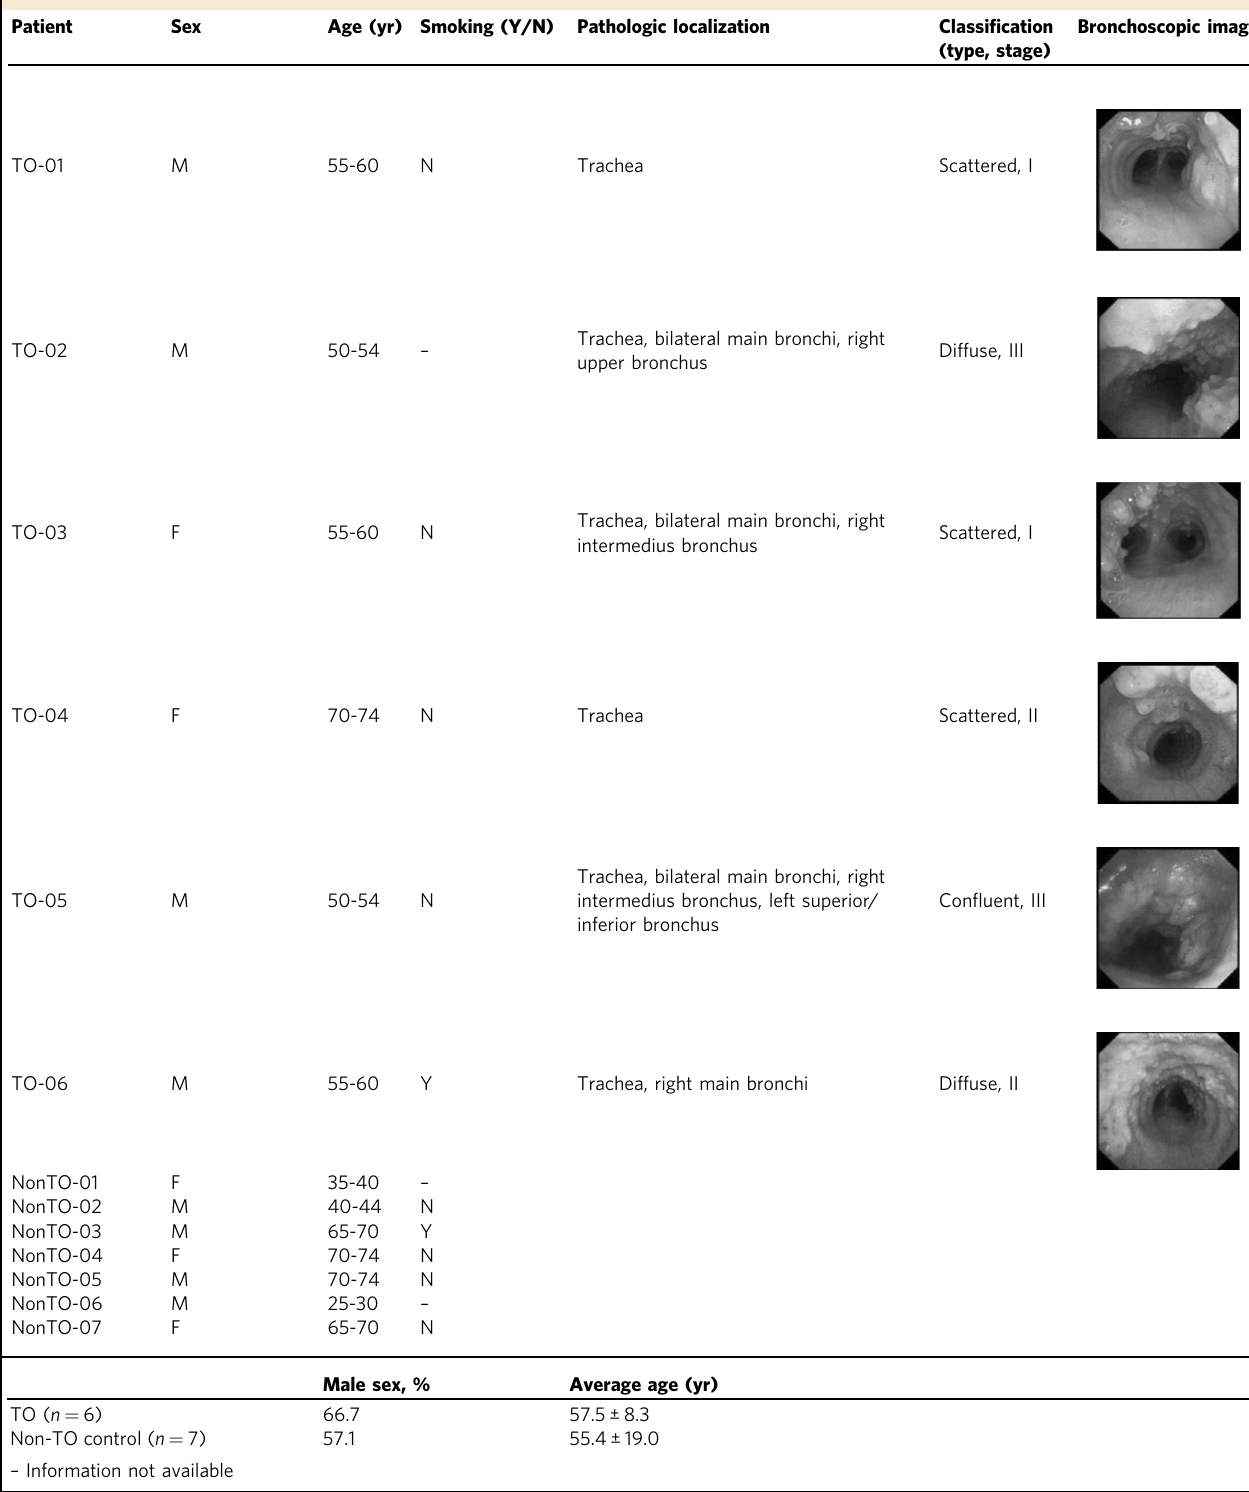
Table 1 Demographics and clinical characteristics of study